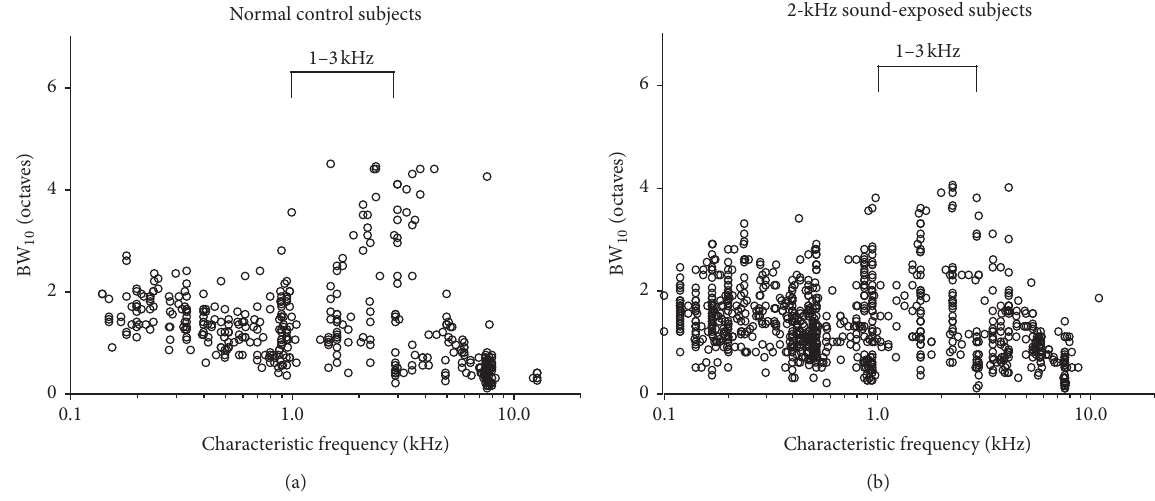
Figure 5: Comparison of frequency tuning bandwidths 10dB above threshold (BW 10 ) in neurons of the central nucleus of IC. There is no difference in BW 10 near the region of the sound-exposure stimulus (1–3kHz) in 5 neonatally sound-exposed subjects ((b); 𝑛 = 968 units) compared with 6 controls ((a); 𝑛 = 422